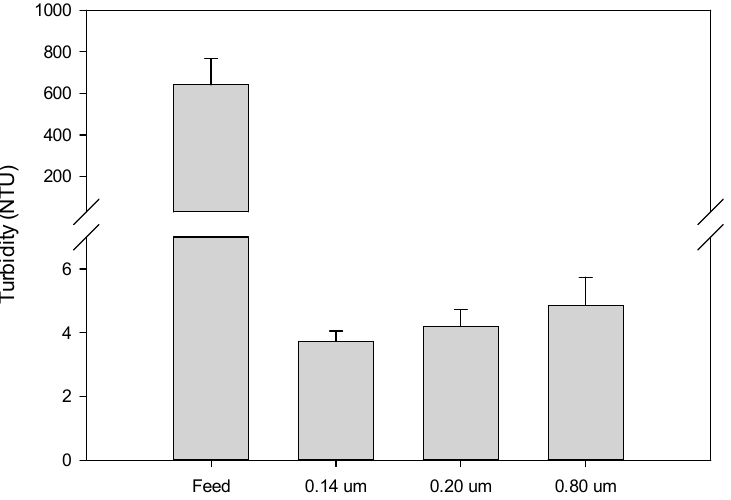
Figure 5. Experimental results and predicted values by the Yee model for the studied membranes.